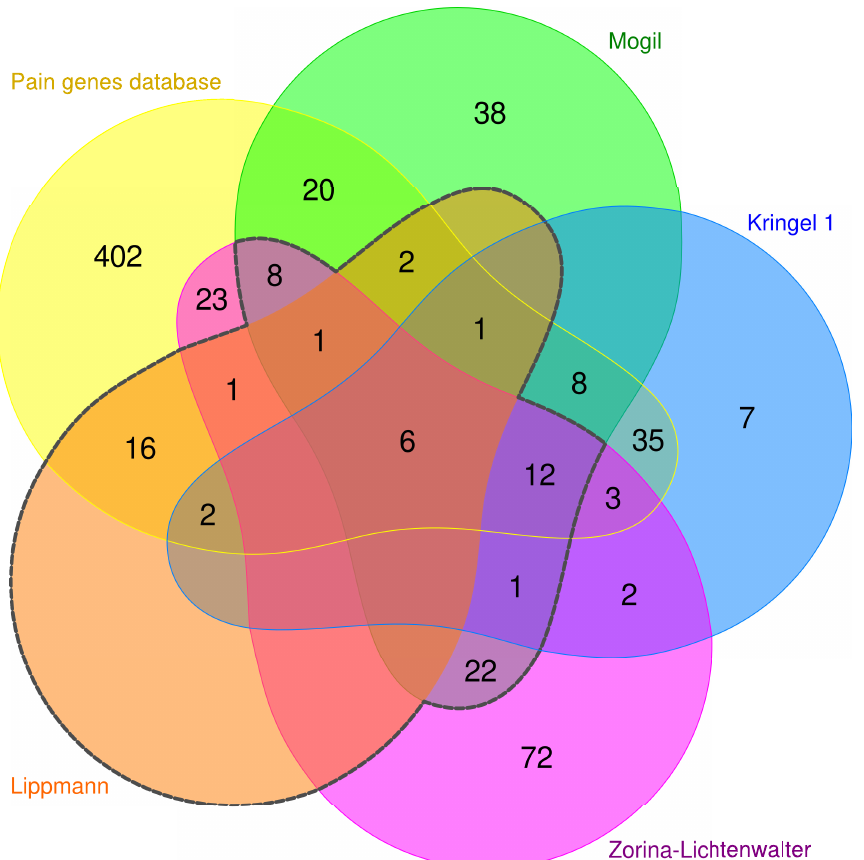
Figure 1. . Figure 1. Assembly of the pain-relevant gene set forming the proposed NGS panel from